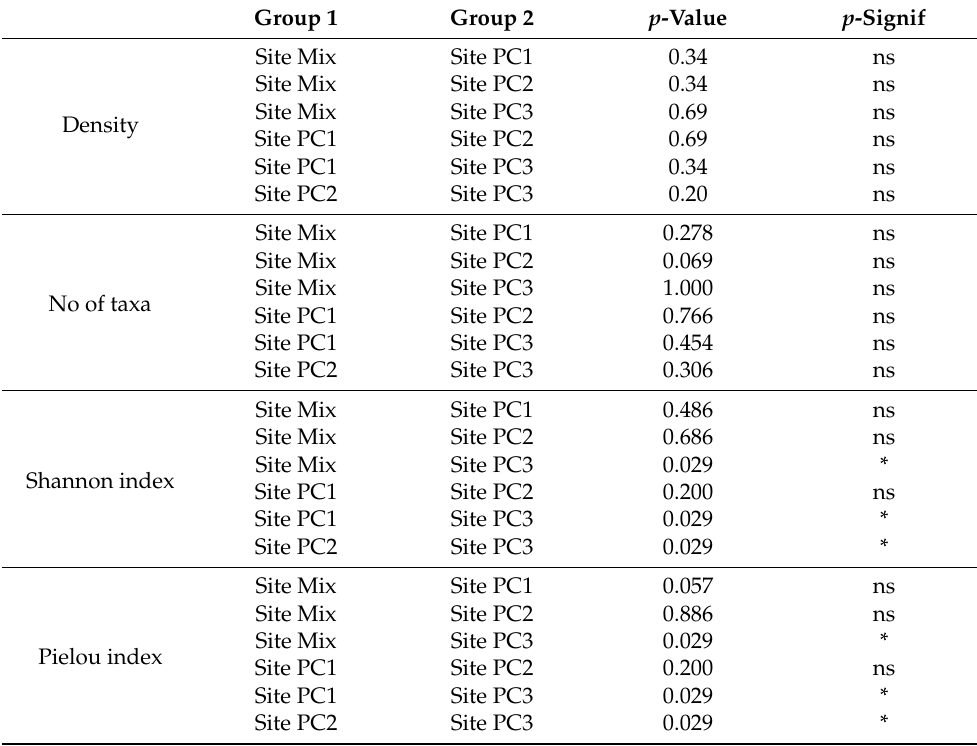
Table A2. Results of univariate tests (Wilcoxon–Mann–Whitney) among P. crispa sites (ns = p > 0.05; * = 0.01 < p < 0.05).